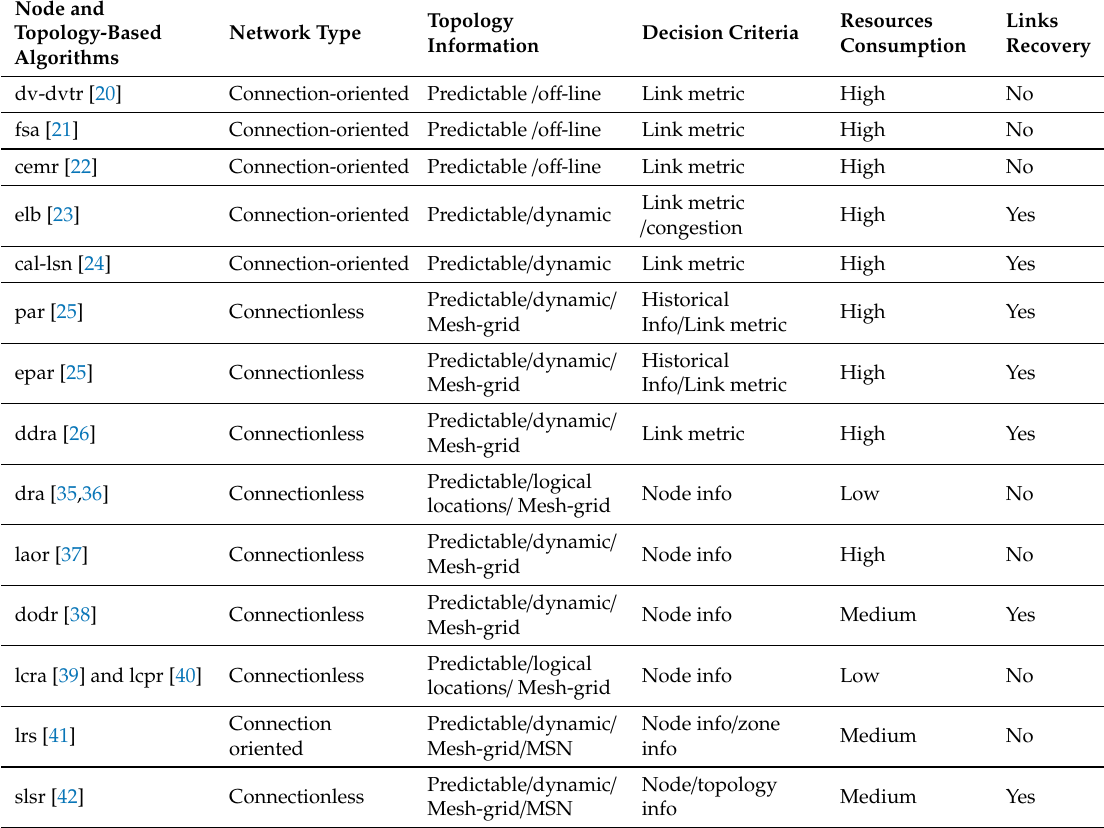
Table 2. Single-layer routing